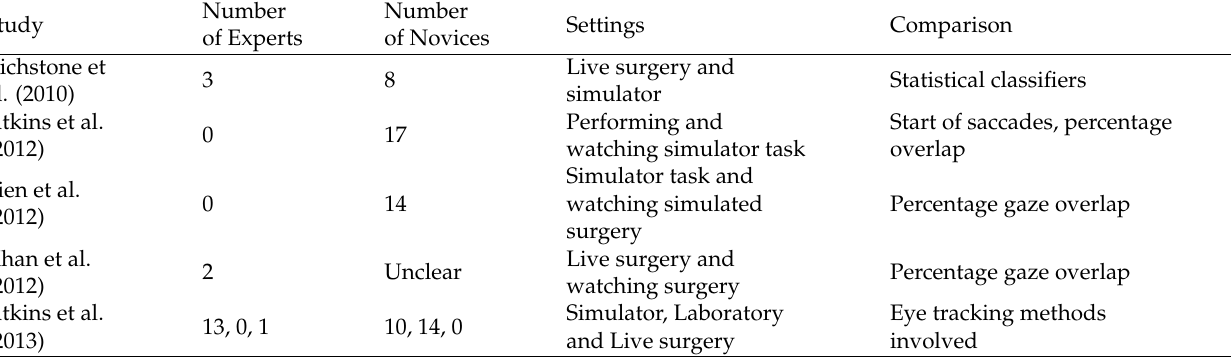
Studies examining the role of context in which eye movements are observed, listing the numbers of experts and novices that participated, the settings and/or tasks that were compared, and the analysis method used for